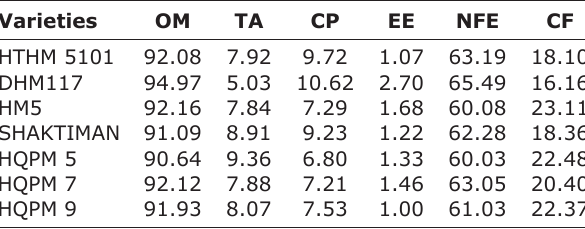
Table-1: Proximate composition (% DM basis) of different varieties of maize fodder. Varieties OM TA CP EE NFE